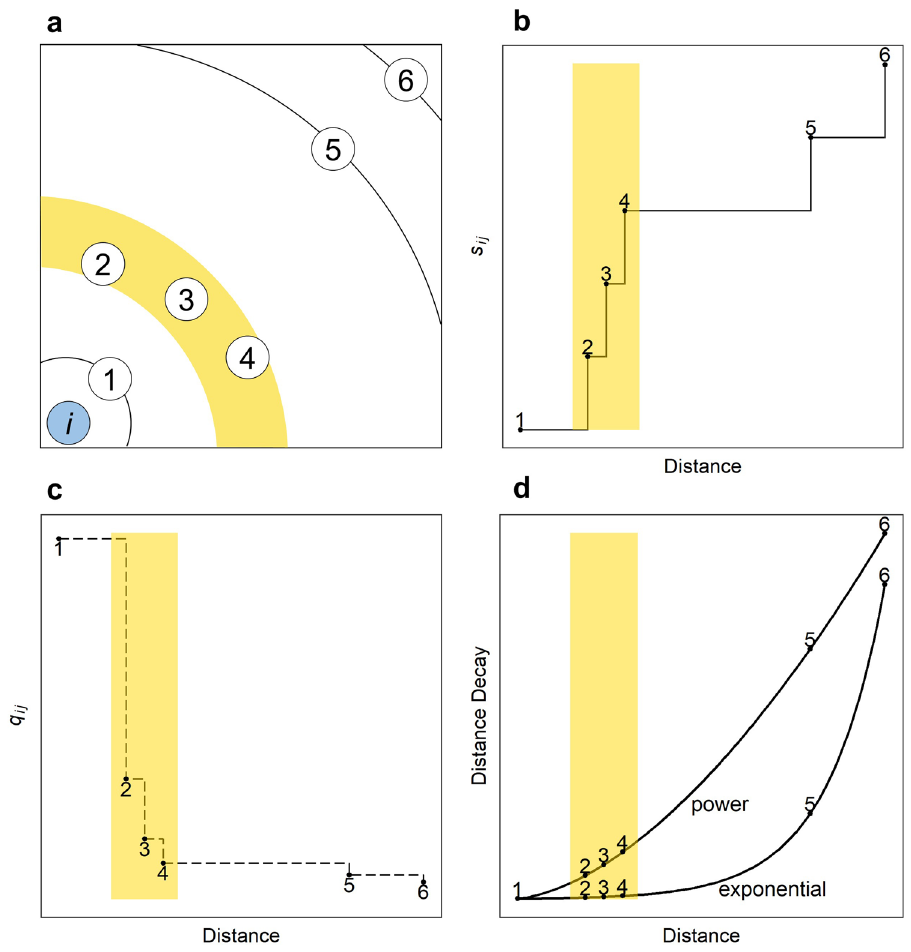
Figure 2. Location setting example and the changes in distance decay curves, s ij , and q ij . ( a ) The location setting example shows that areas 2, 3, and 4 locate almost the same distance from the origin. ( b ) The intervening opportunities for the setting. ( c ) The normalised probability q ij that an individual selects the destination j from origin i for the setting. ( d ) distance decay effect for the